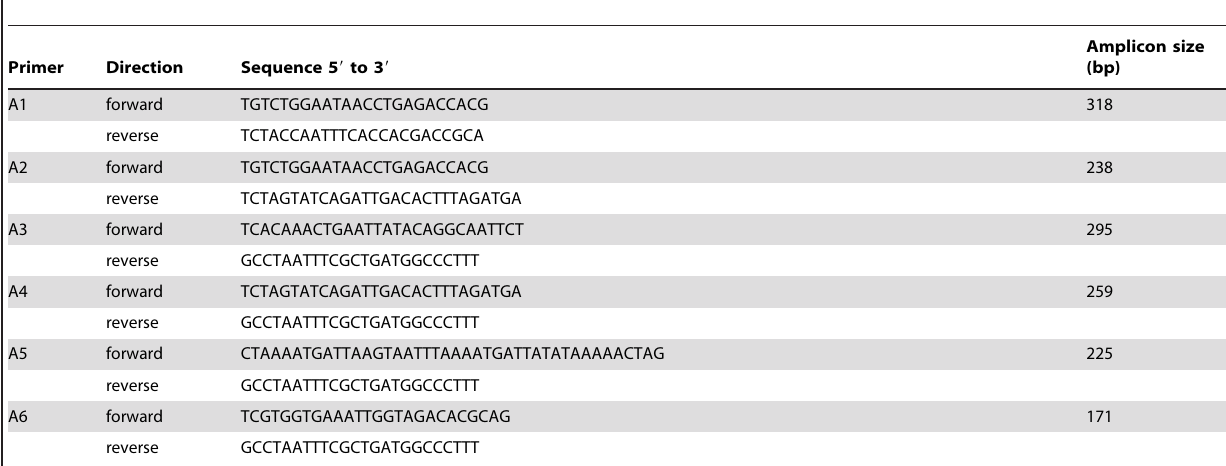
Table 4. Primers used to identify minimal binding region in ribA